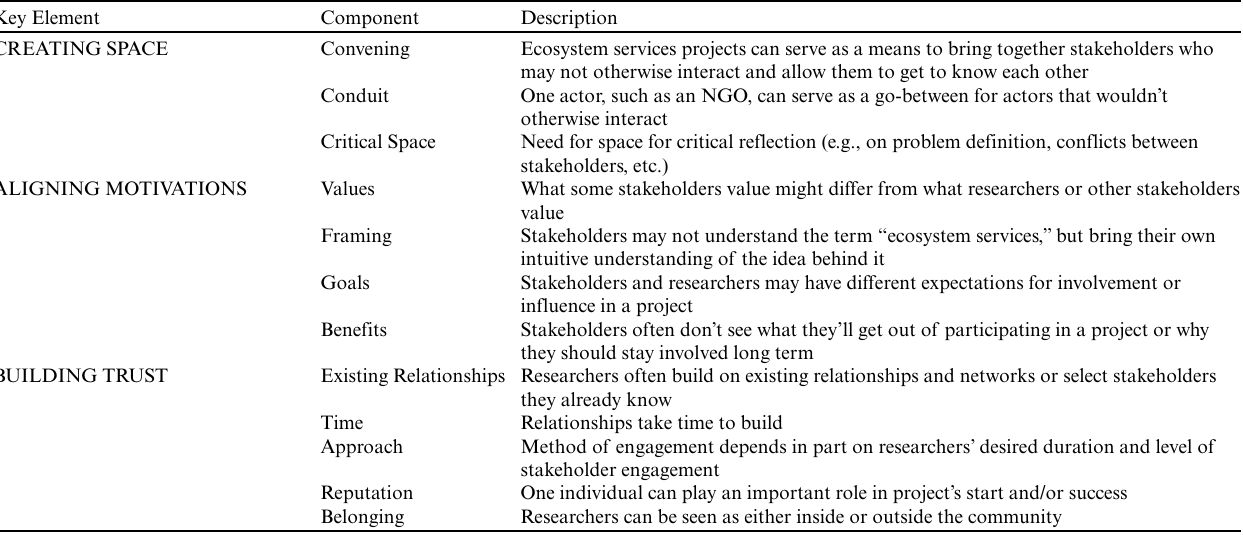
Table 2. Framework for effective stakeholder engagement in ecosystem services research, consisting of three key elements and their constituent 12 components. These elements were identified inductively via qualitative analysis of interview responses from researchers leading 12 European ecosystem services research case